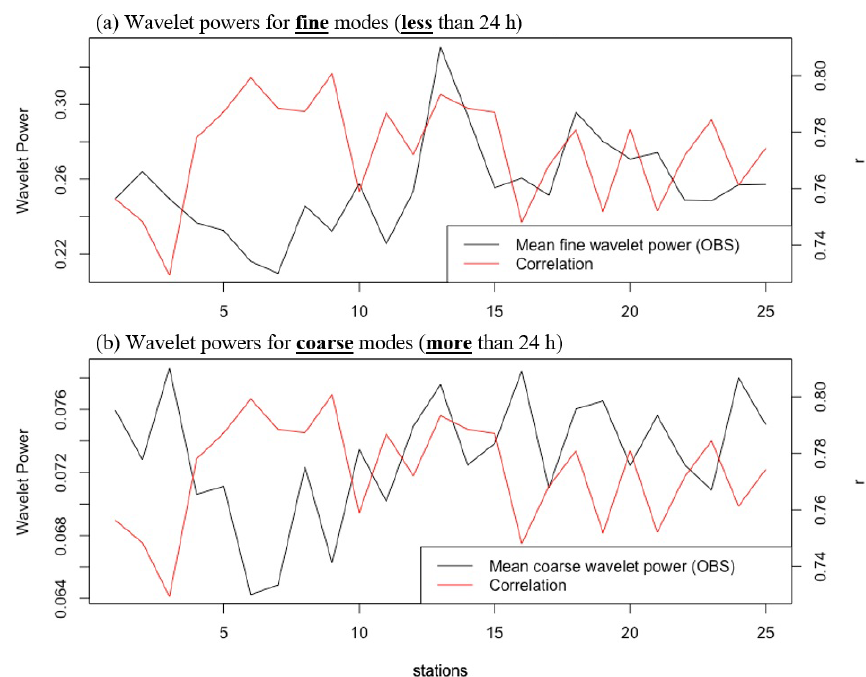
Figure 4. Relationship between (a) fine and (b) coarse wavelet power modes and correlation coefficients in all stations in Seoul, South